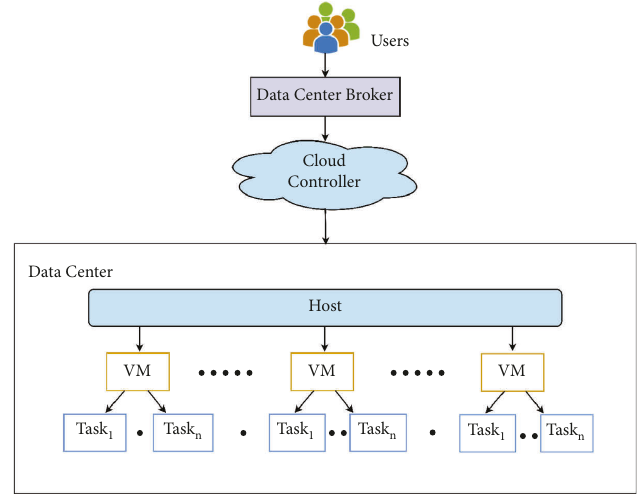
Figure 1: The architecture of the VM scheduling